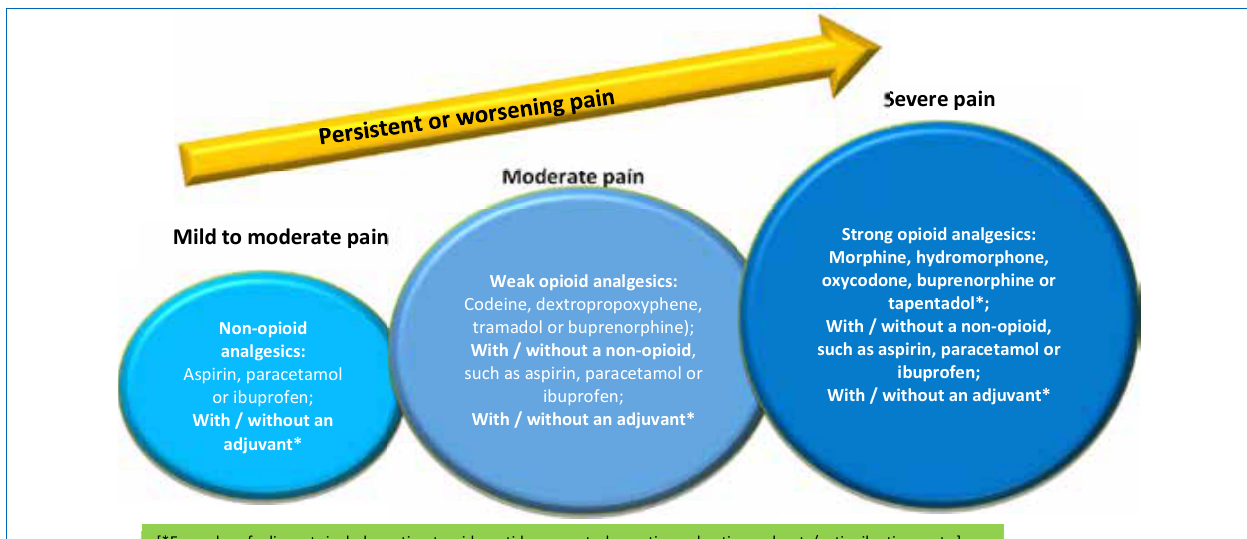
Figure 8: The World Health Organization’s three-step analgesic guideline 30